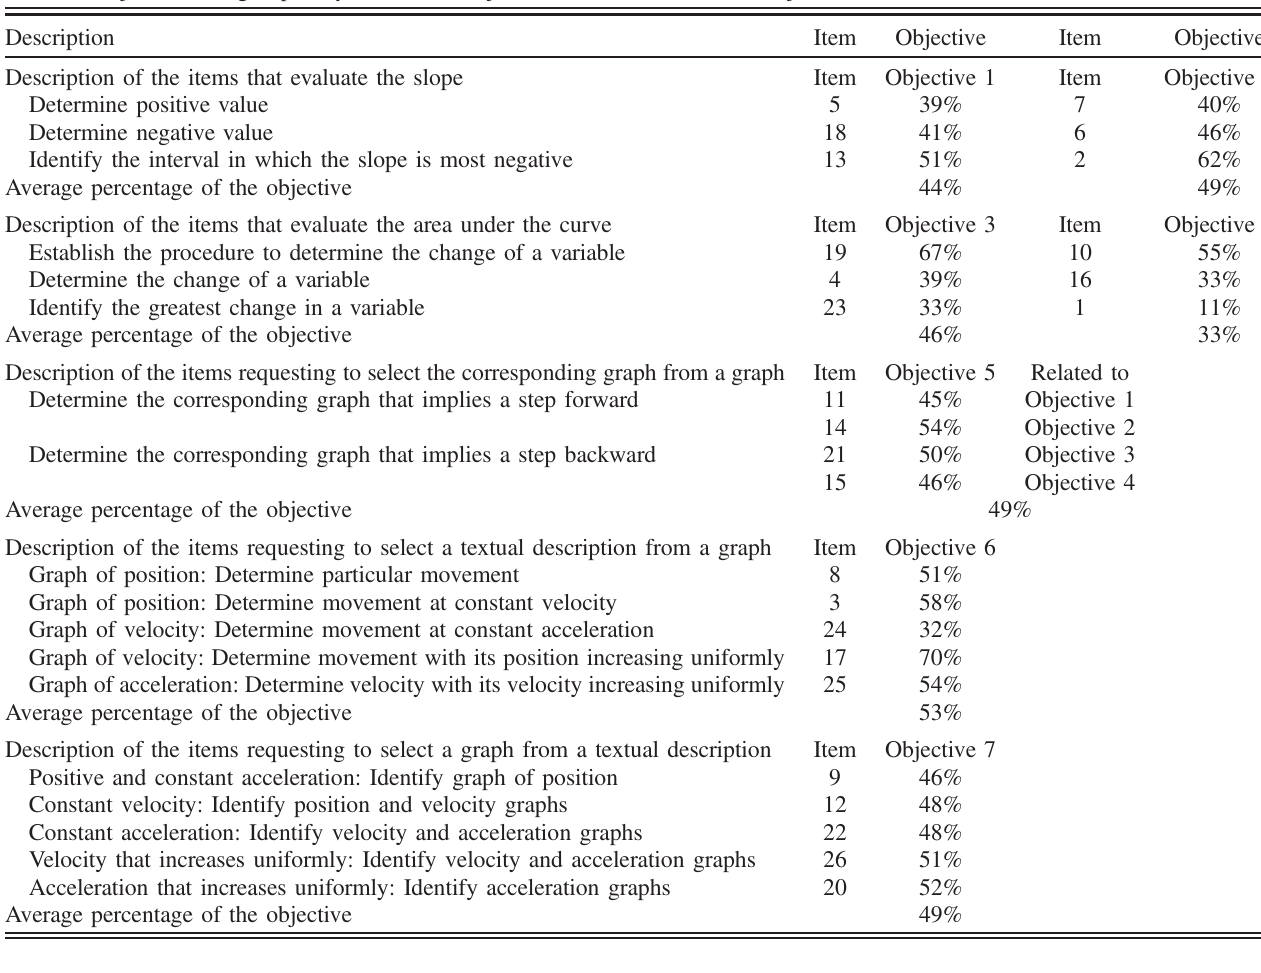
TABLE XIII. Percentage of the correct answer of the items and the average of each objective organized by objectives. The items of the four first objectives are grouped by the related objectives 1 and 2 and related objectives 3 and